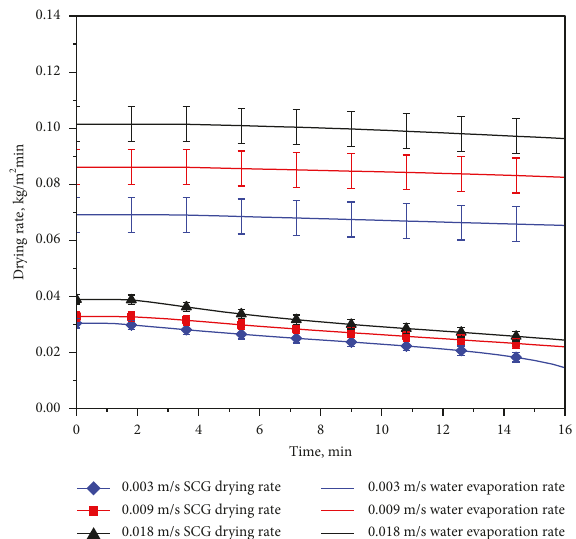
Figure 7: Comparison between the drying rate of spent coffee grounds and the water evaporation rate at 70 ° C and furnace air velocities of 0.003, 0.009, and